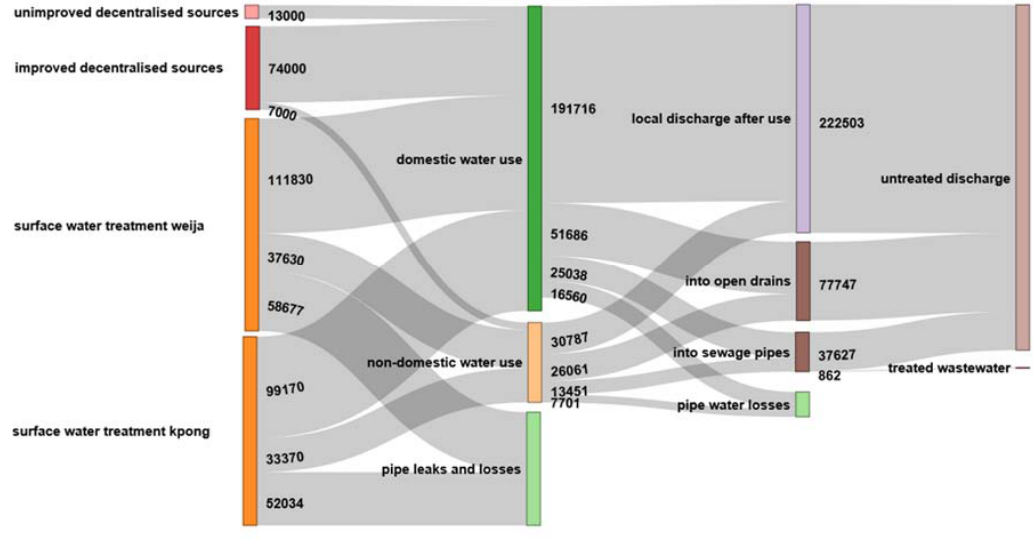
Figure 4. Sankey diagram from 2010 GAMA raw water treatment to final wastewater discharge flows in m 3 per day.